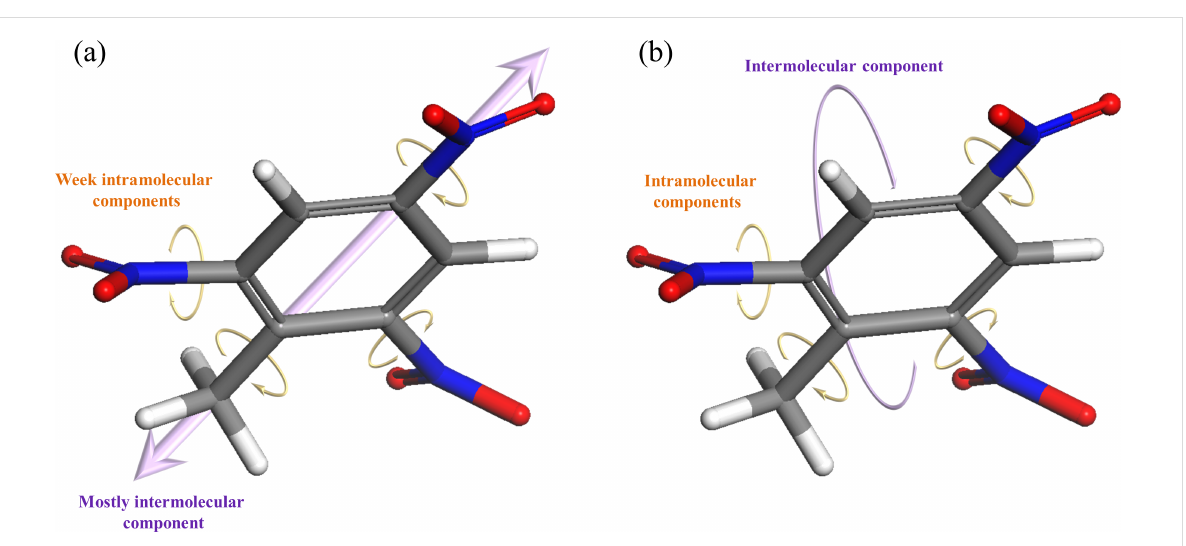
Figure 3: Schematic representation of typical TNT vibrational modes, demonstrated using modes of the orthorhombic polymorph at frequencies of (a) ca. 1.0 THz, (b) ca. 2.3 THz. Purple and orange arrows denote the direction of primary inter- and intramolecular displacement components.